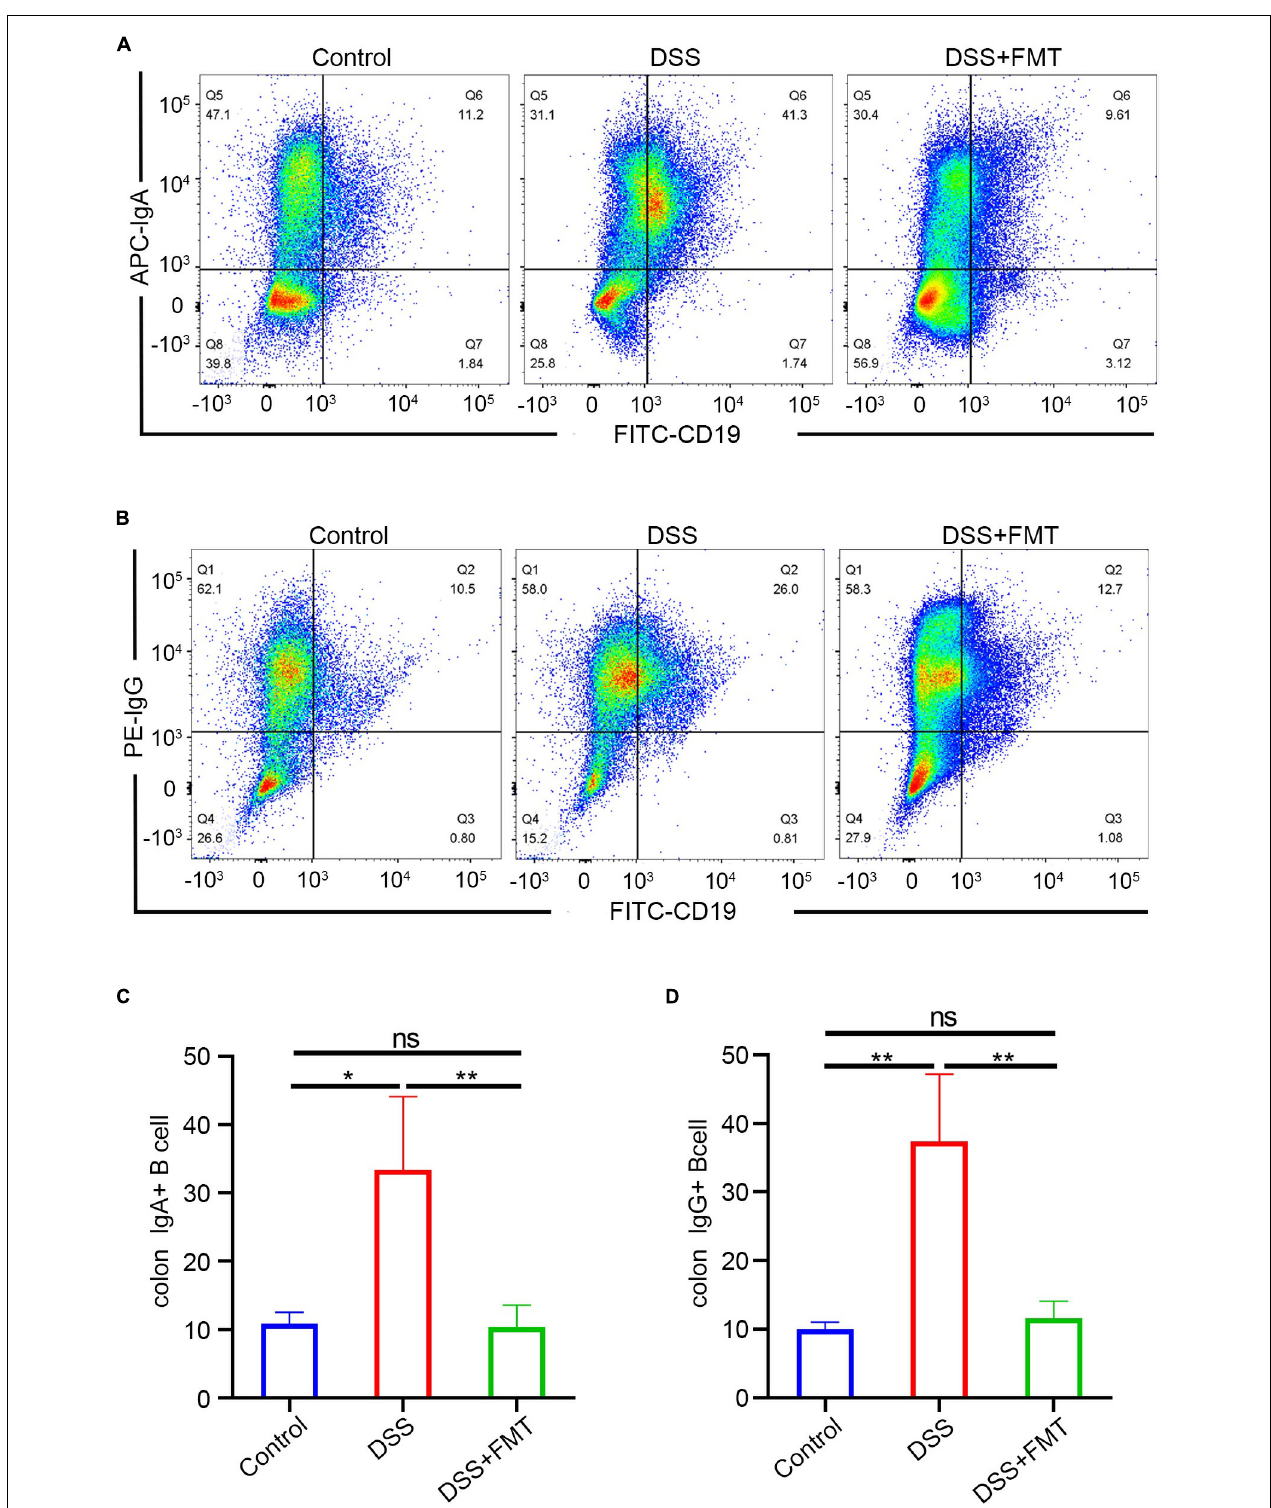
FIGURE 9 | IgA/G memory B cells of the intestine were determined by flow cytometry. (A,C) IgA memory B cells by FACS. (B,D) IgG memory B cells by FACS.